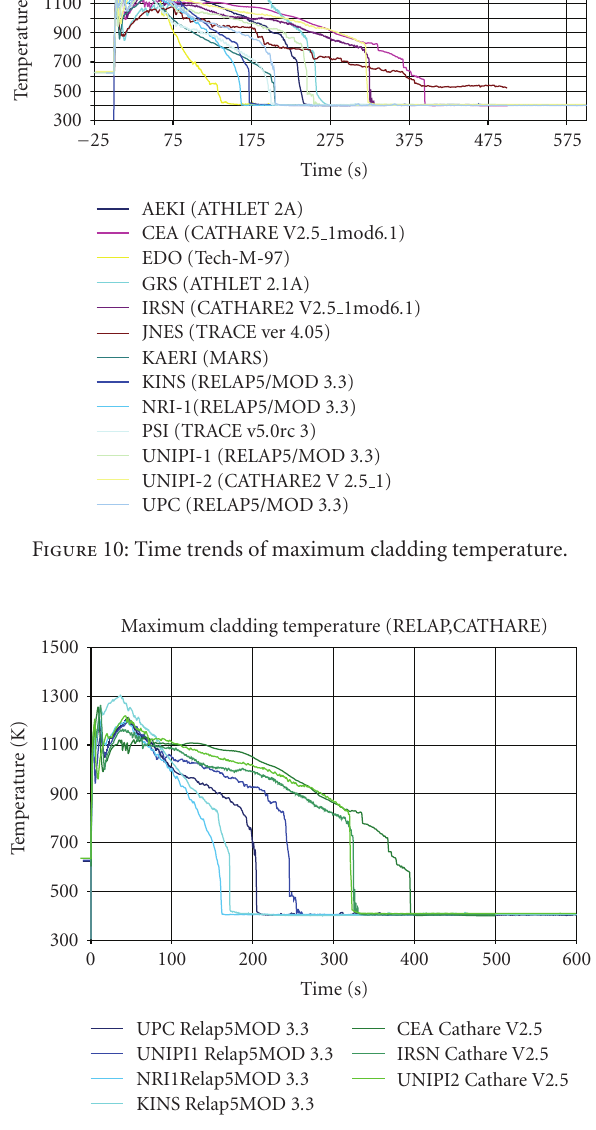
Figure 11: Calculated hot rod temperature/Code e ff ect considera-